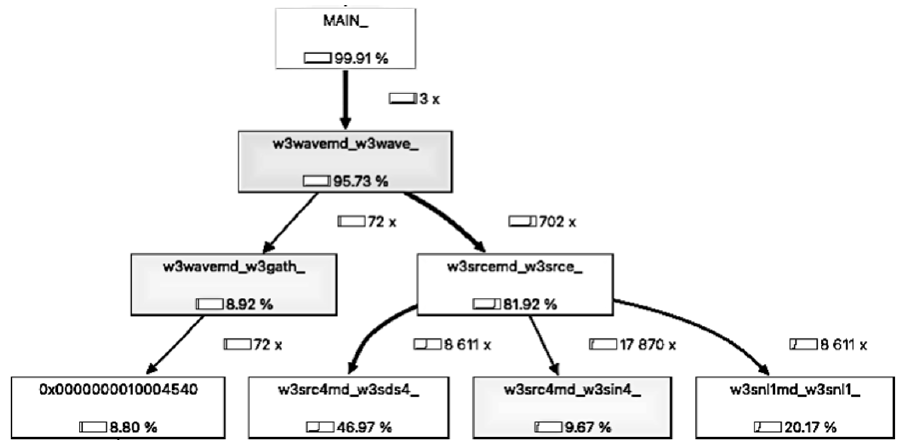
Figure 4. The call graph obtained by profiling WAVEWATCH III with 300 CPU cores on Summit. Each box includes the name of the subroutine and its relative execution time as a